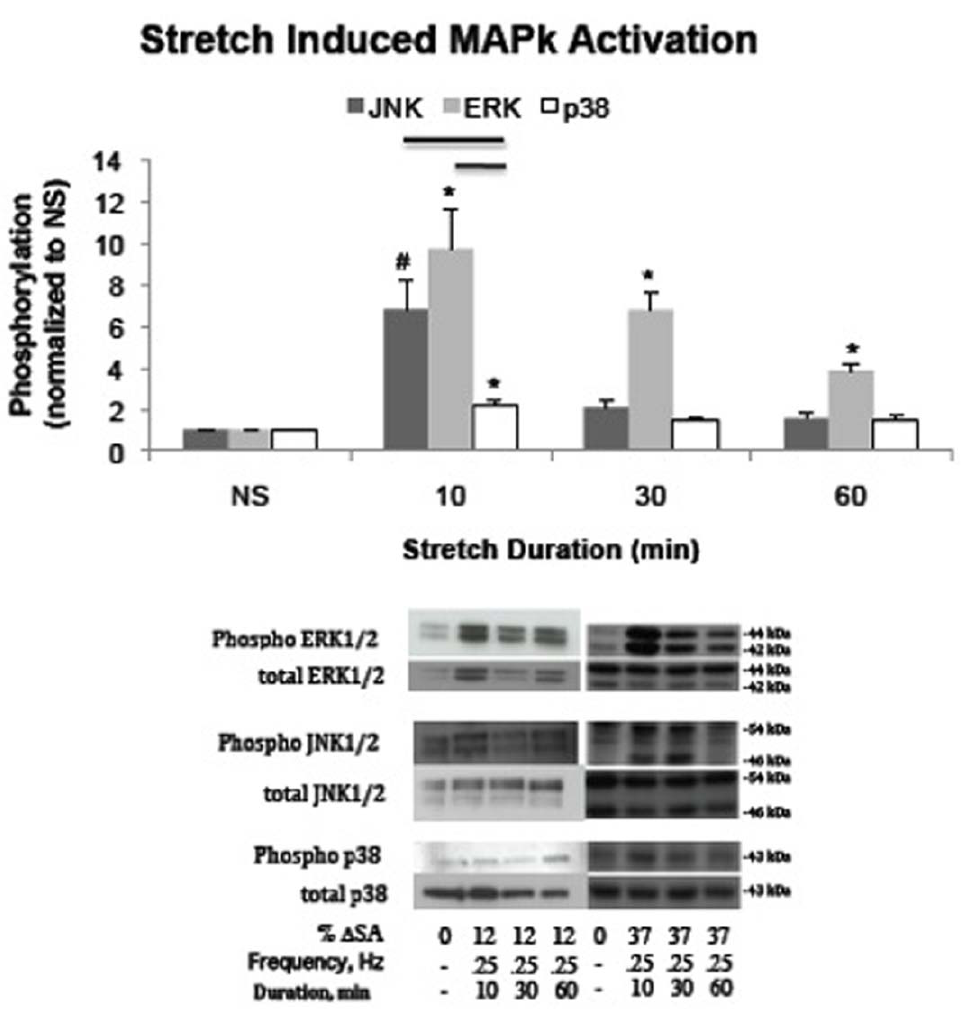
Figure 1. Stretch activation of MAPk signaling. Phosphorylation levels of JNK, ERK, and p38 MAPk following 10, 30, and 60 minutes of cyclic stretch at a rate of 0.25 Hz to a peak magnitude of 37% D SA normalized to unstretched controls. Phosphorylation levels of all MAPks significantly increased above unstretched levels (value of 1) following 10 minutes of stretch (*). Following 30 or 60 minutes of stretch, only ERK remained significantly elevated. JNK phosphorylation was significantly greater following 10 minutes than following 60 minutes ( # ). At the 10 minute time point, phosphorylation of JNK and ERK was significantly higher than phosphorylation of p38. Significance is defined as p , 0.05. Representative western blots of phosphorylated and total MAPks following stretch to either 12% or 37% D SA are also shown. No change in phosphorylated protein normalized to total protein was observed at any stretch duration with a stretch magnitude of 12% D SA.